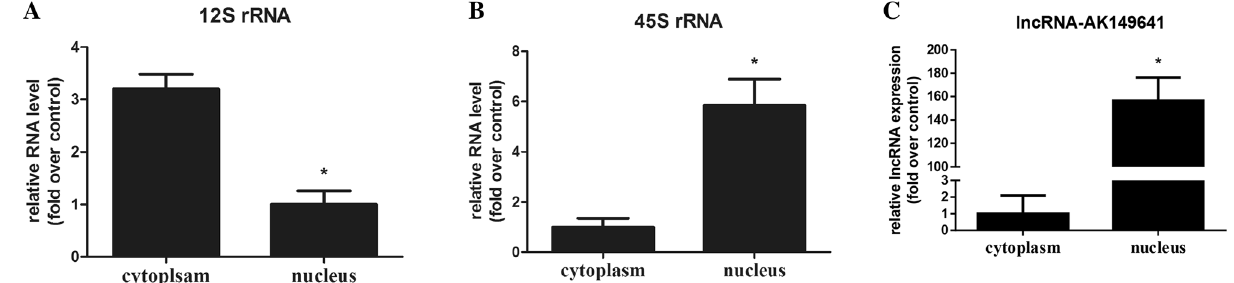
Figure 4. Expression levels of 12S rRNA, 45S rRNA, and lncRNA-AK149641 in the nucleus and cytoplasm of P815 mast cells (* P < 0.05, n =